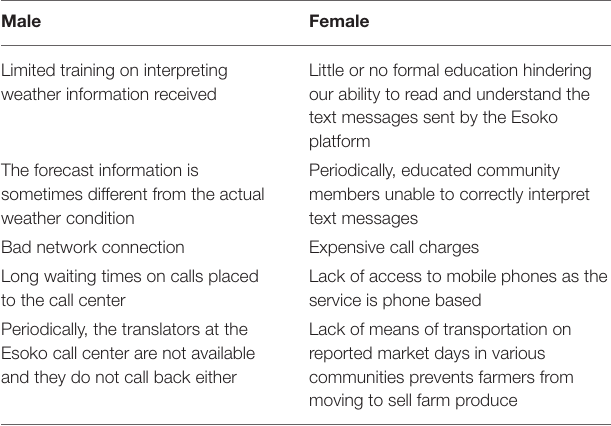
TABLE 3 | Constraints to effective use of climate information delivered through mobiles phones in the CCAFS CSV sites in the Lawra-Jirapa district of the Upper West Region of